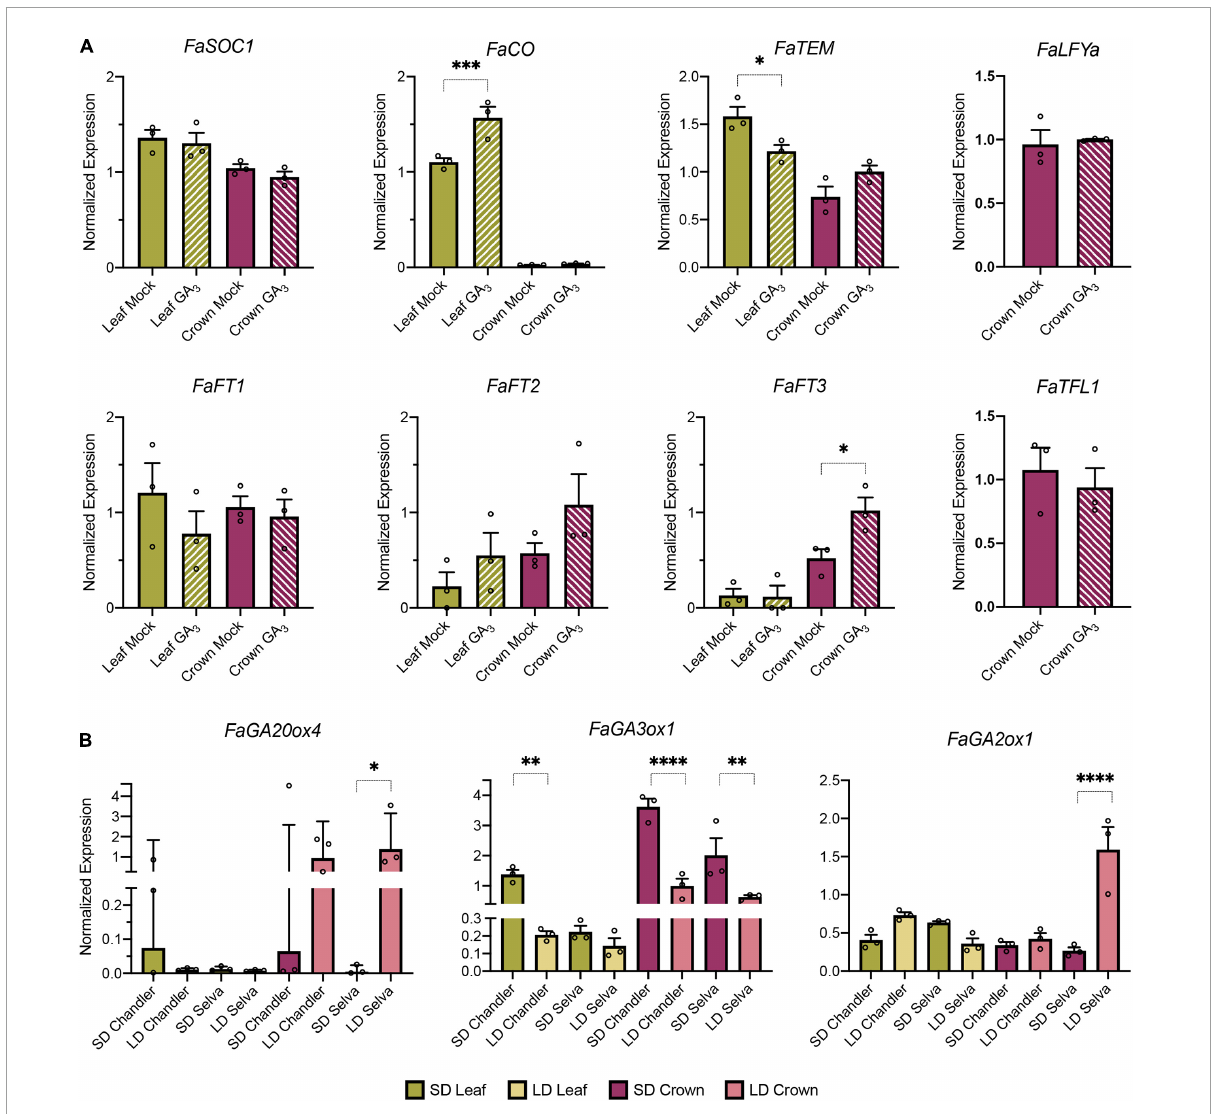
FIGURE7 Role of GA in the shift between floral and vegetative development in F. × ananassa. (A) Flowering time gene expression in response to exogenous GA 3 treatment in leaves (green) and crowns (purple) from SF ‘Camarosa’ plants. (B) GA metabolism gene expression in leaves and crowns from the SF cultivar Chandler and the PF cultivar Selva collected under SD and LD. Graphs show the average of normalized values from three biological replicates ± SEM. In each bar, dots represent the normalized value of each biological replicate. * p < 0 . 05, ** p < 0 . 01, *** p < 0 . 001, **** p < 0 .